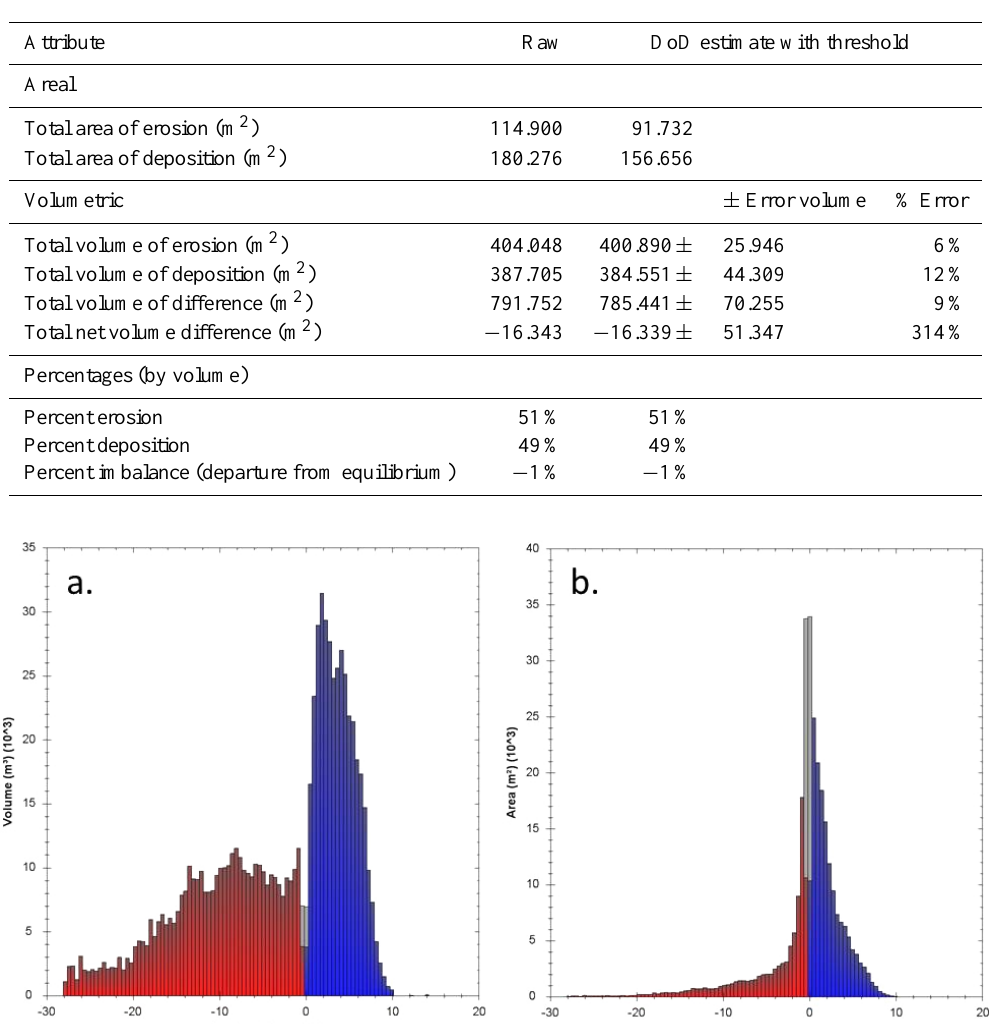
Table 1. Main results of the DoD analysis.